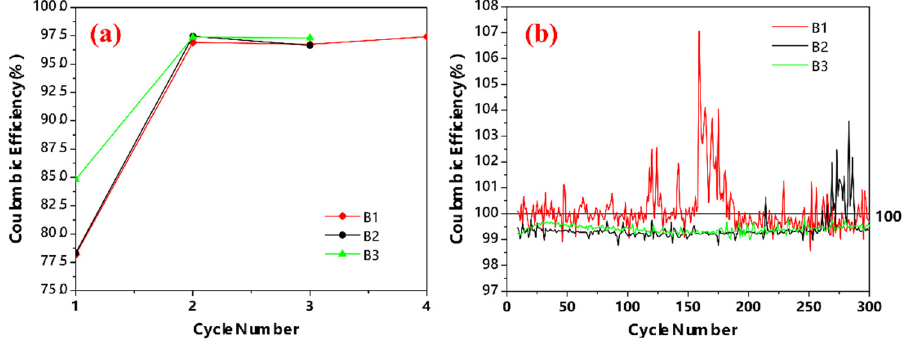
Figure 7. The Coulombic efficiencies of B1, B2, and B3 cells as a function of ( a ) cycle number in formation cycles and ( b ) cycle number in service cycles. formation cycles and ( b ) cycle number in service